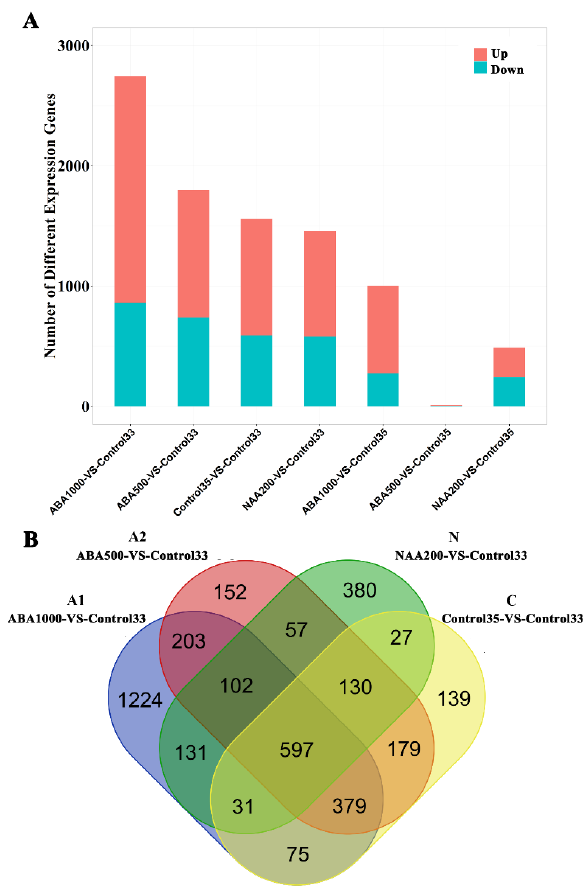
Figure 3. ( A ) Differentially expressed genes (DEGs) between the different samples. Former four bars represent the number of DEGs in the E-L 35 stage (ripening initiation) relative to Control33; last three bars represent the number of DEGs in the E-L 35 stage compared to the samples of Control35. Red and cyan bars represent the number of up-regulated and down-regulated genes, respectively. ( B ) Venn diagram summary of the four DEG sets: A1, ABA1000 vs. Control33; A2, ABA500 vs. Control33; C, Control35 vs. Control33; N, NAA200 vs. Control33.